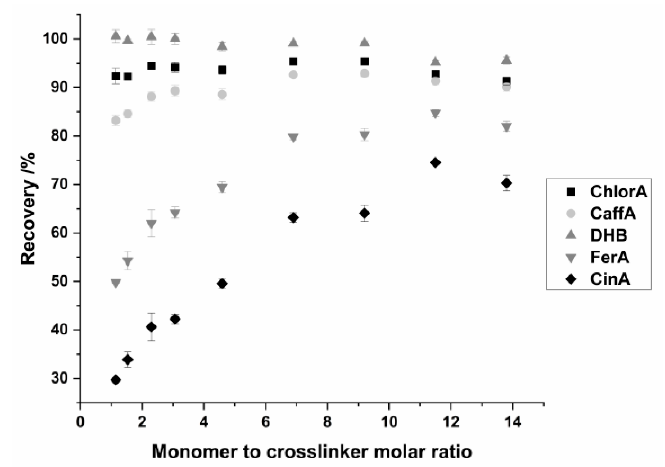
Figure 4. Analyte recovery results obtained from DSPE experiments with [C 6 -bis-VIM] [Br] crosslinked vinylimidazole polymers with different monomer to crosslinker ratios. Standard deviations are given as error bars.